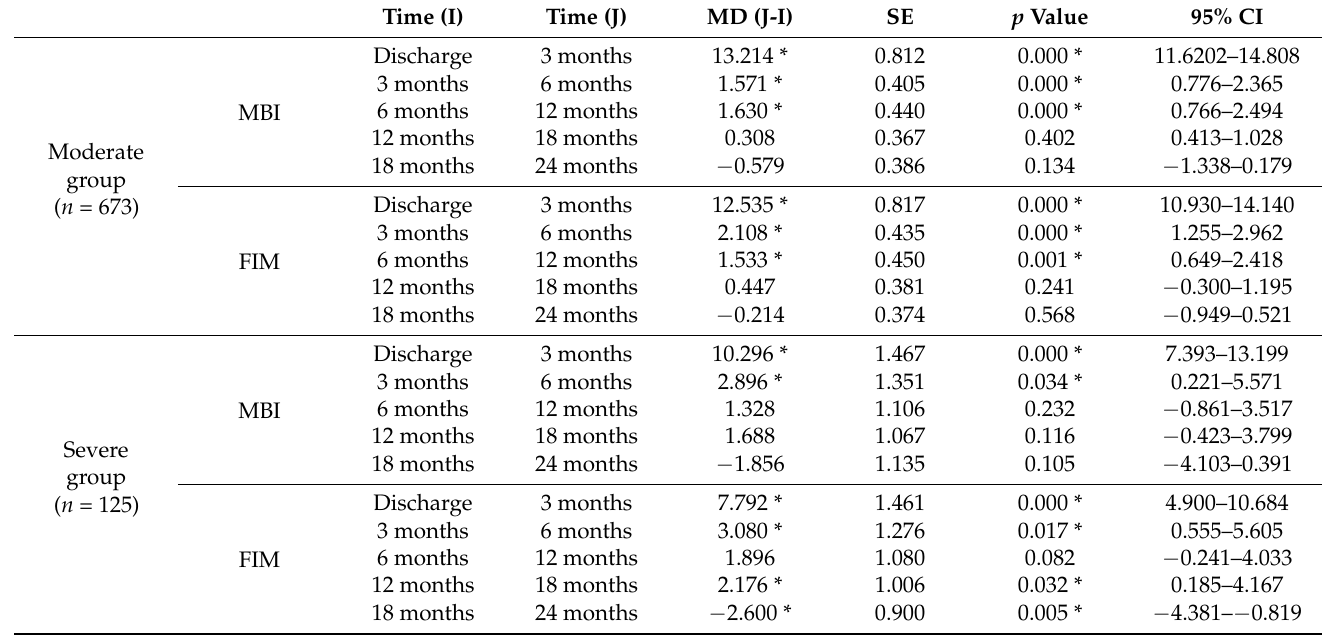
Table 4. Changes in the mean MBI and FIM total scores by time period for moderate and se- vere